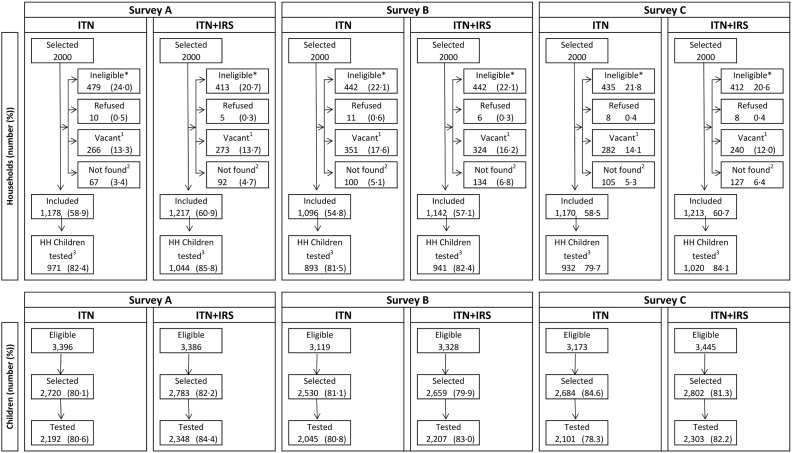
Trial profile for study households and children in the ITN only and ITN+IRS study arms.Note: Survey A = 2 months after first intervention spray. Survey B = 6 months after first intervention spray and 2 months after second intervention spray. Survey C = 10 months after first intervention spray and 6 months after second intervention spray. *No children 0.5–14 y old. 1Dwelling vacant for survey duration. 2Includes not found (91.0%), not visited (2.4%), and missing data (6.6%). 3Households (HH) that were included and where children attended for testing.